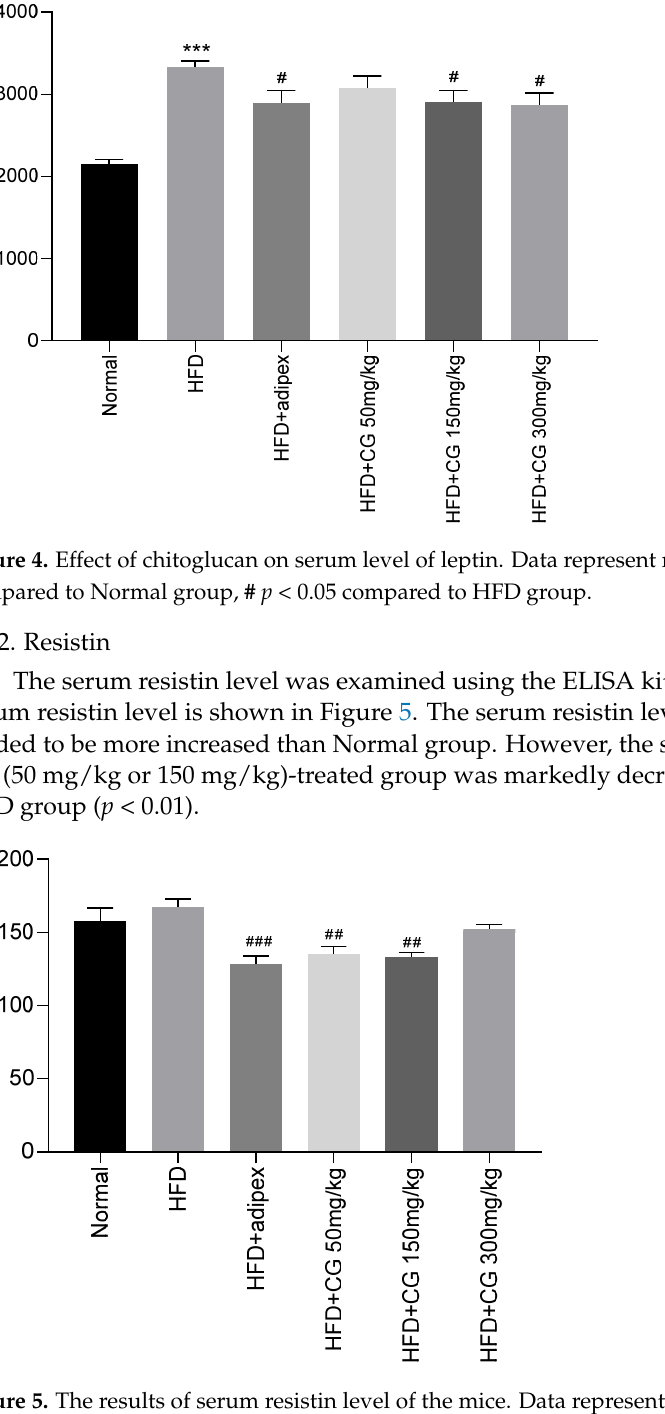
Figure 3. Effect of chitoglucan on fat weight. Data represent means ± S.E.M. *** p < 0.001 compared with Normal group, ### p < 0.001 compared with HFD group.